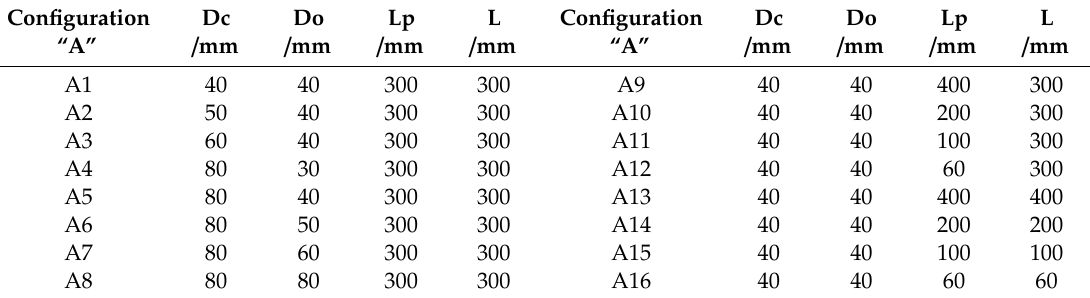
Table 3. Design details of configurations “B” and “C”.